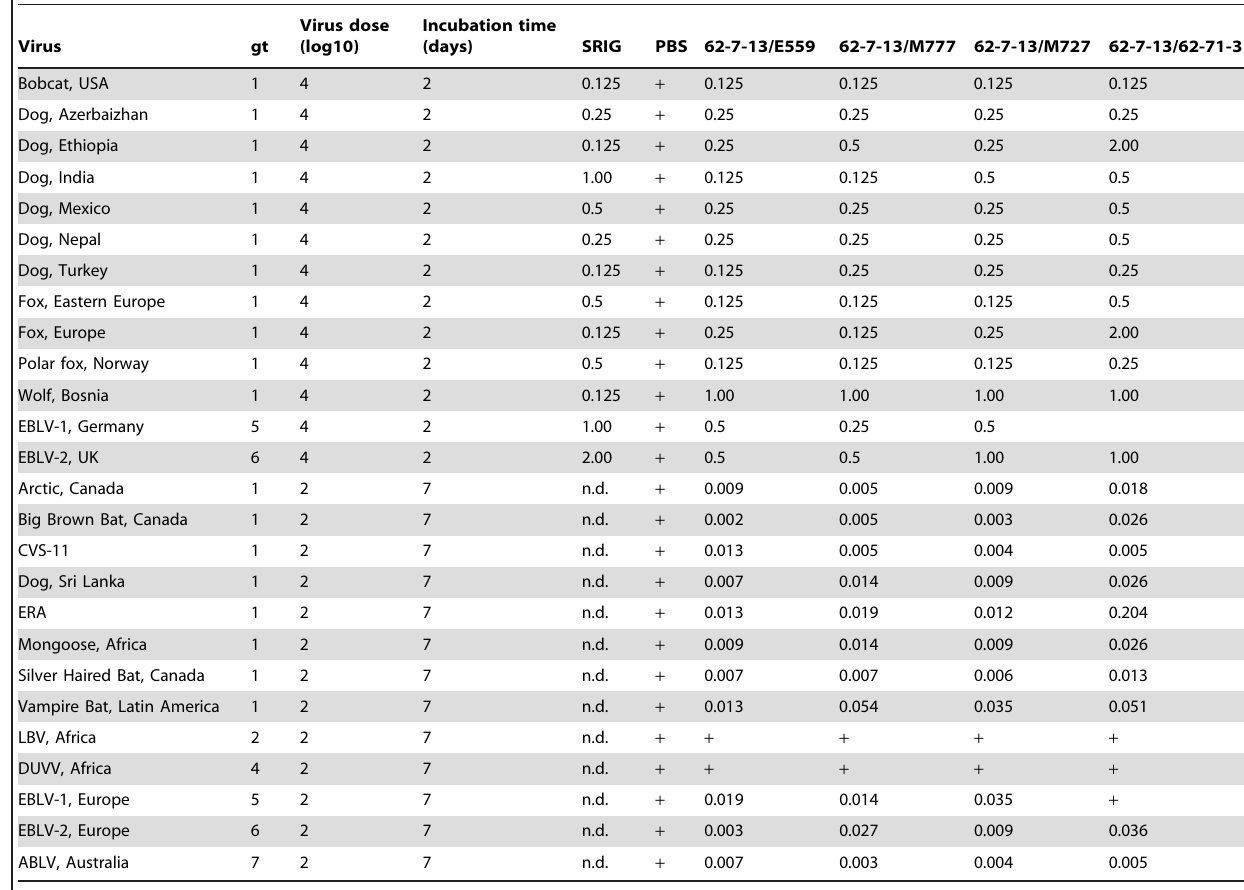
Table 6. In vitro neutralization pattern of equal amounts of MoMAbs in combination cocktails.